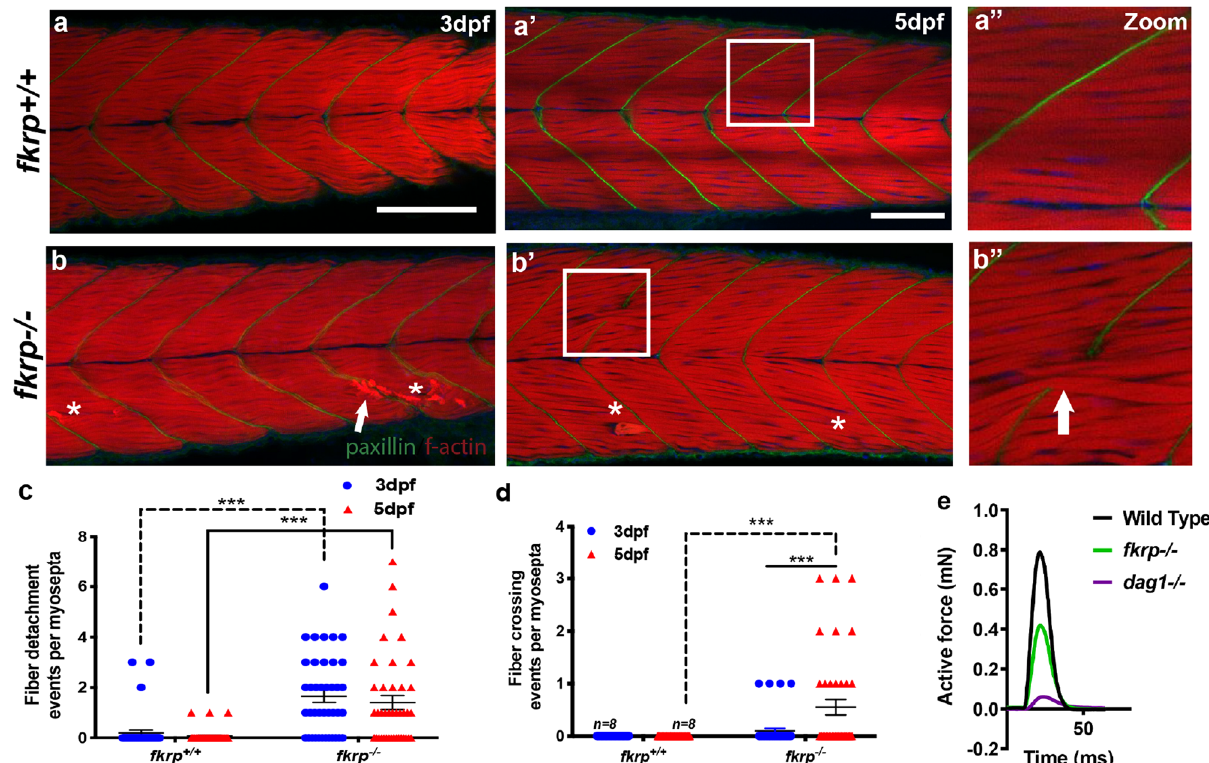
Fig. 1 fkrp − / − fi sh possess a basement membrane failure phenotype. a – d Muscle fi bre-crossing and detachment phenotypes at the muscle basement membrane of fkrp − / − mutant larvae. a – b ” Z-projected images from the entire mediolateral extent of the myotome centred on the region of the anal pore. Phalloidin conjugated to TRITC (red) stains for f-actin as a marker of skeletal muscle and paxillin (green) visualises vertical myosepta muscle basement membrane integrity. White arrowheads: muscle fi bres crossing at defective muscle basement membranes, asterisks: muscle fi bre detachment. 3 dpf, scale bar = 100 μ m. 5 dpf, scale bar = 75 μ m, white boxes in a ’ , b ’ denote the high-magni fi cation views presented in a ” and b ” . c , d Quantitation of fi bre detachment ( c ) and basement membrane crossing events ( d ) per myosepta in wild-type ( n = 9) or fkrp mutant larvae ( n = 9) over fi ve independent experiments, analysed using two-way ANOVA multiple comparisons assuming non-parametric data, the signi fi cance of ***( P = < 0.0001), error bars represent SEM. e Physiological analysis of muscle function. The maximum active force (mN) generated over a speci fi c time interval (ms) was measured in individual genotypes of 6 dpf larvae represented in single-twitch recordings of fkrp + / + sibling (sib) black line ( n = 8), fkrp − / − green line ( n = 6) and dag1 − / − purple line ( n =